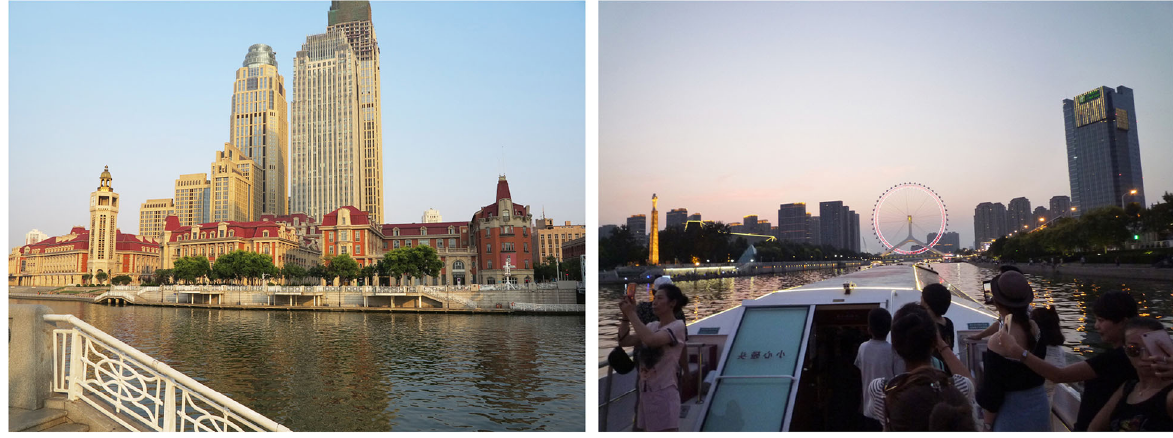
Fig. 4 The banks of the Hai River in Tianjin (Source: Christine Mengin and Emilie Rousseau,